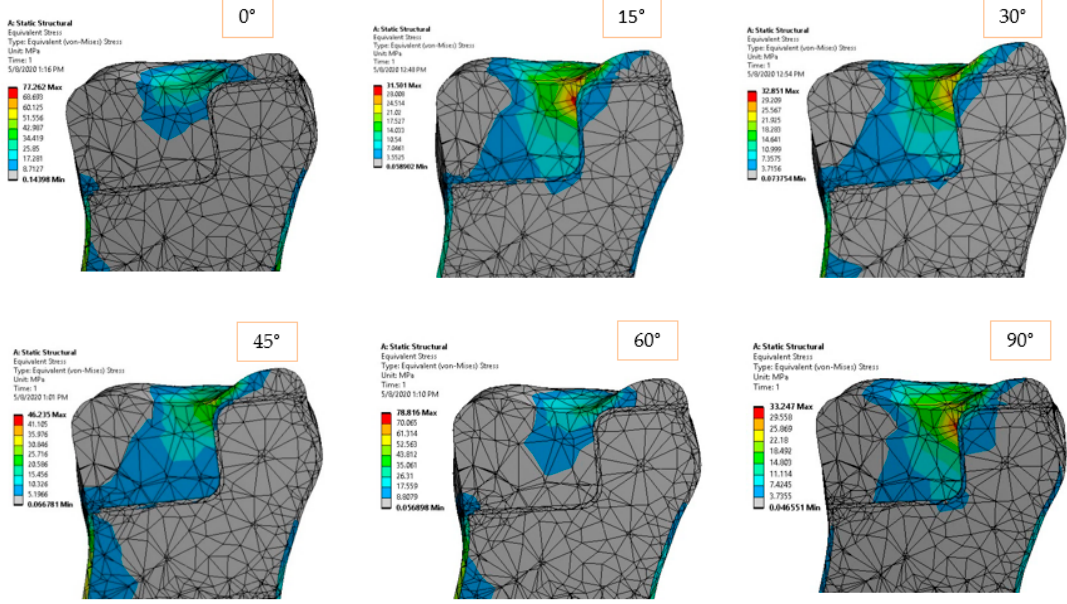
Figure 12. Equivalent elastic stress for 170 N load and 0°–90° loading direction.